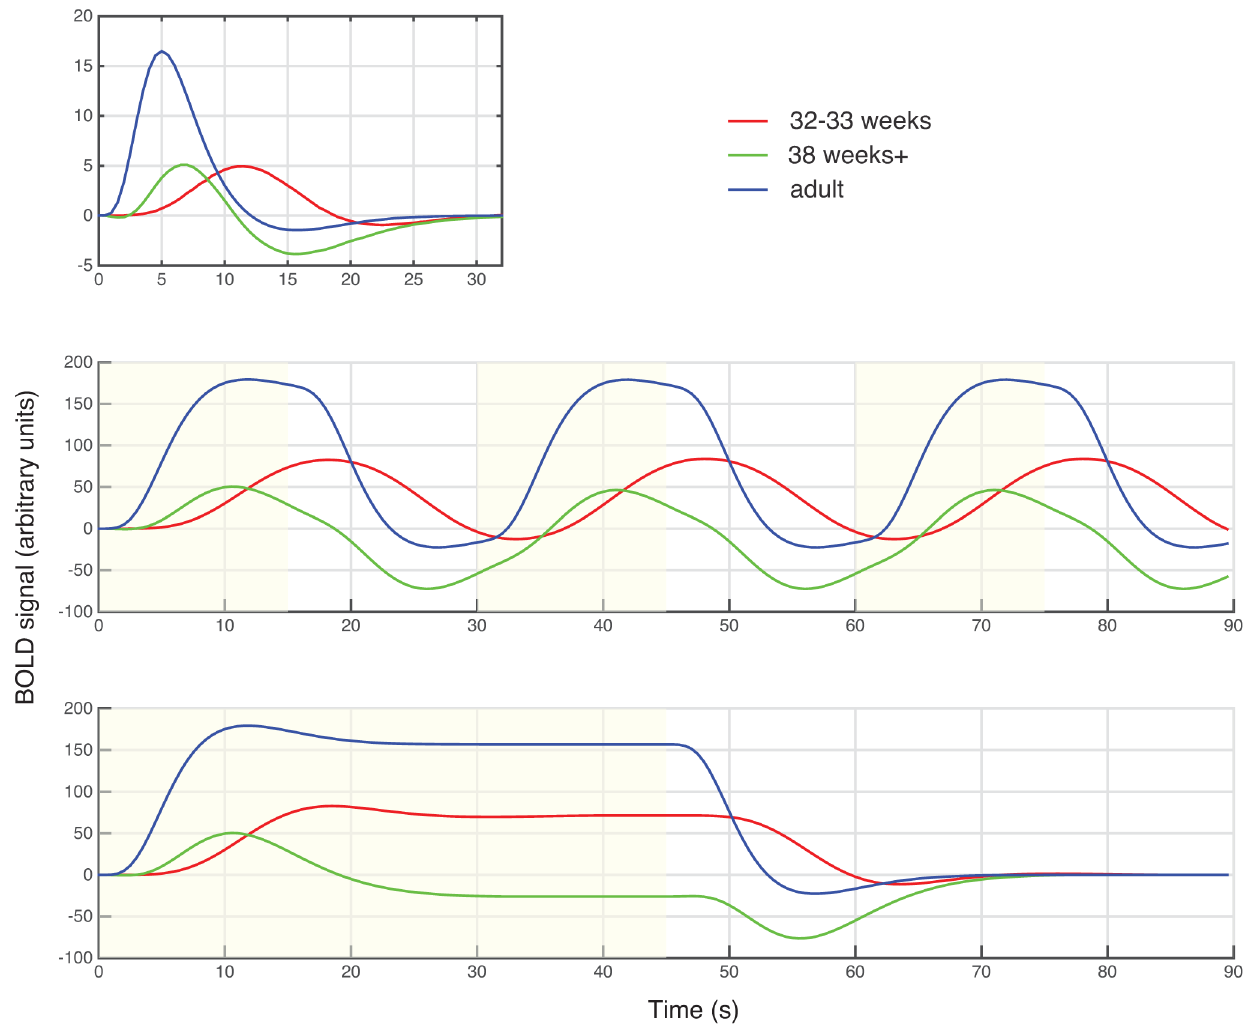
Fig 1. (a) The hemodynamic response (HRF) to a brief 1-second stimulation at three ages (Arichi et al, 2012). In adults the HRF is dominated by a positive peak, while at 38 weeks gestational age (GA) neonates have positive and negative peaks of similar magnitude. At 32 weeks GA the HRF is dominated by a positive peak, but it is much delayed. (b) The form of the HRF affects the power of different stimulation designs. To illustrate this, the response to a 30s-long cycle of stimulation (yellow) and rest was calculated by convolving the HRFs with a boxcar. For this design, at all three ages, there was substantial modulation of the BOLD signal through time. The signal in adults and 38 week infants was highly correlated, but at 32 weeks the signal has a different phase. (c) In contrast, for 45s of stimulation is followed by 45s of rest, the 38 week infants only have small peaks of modulation in the BOLD signal, and so much reduced power would be